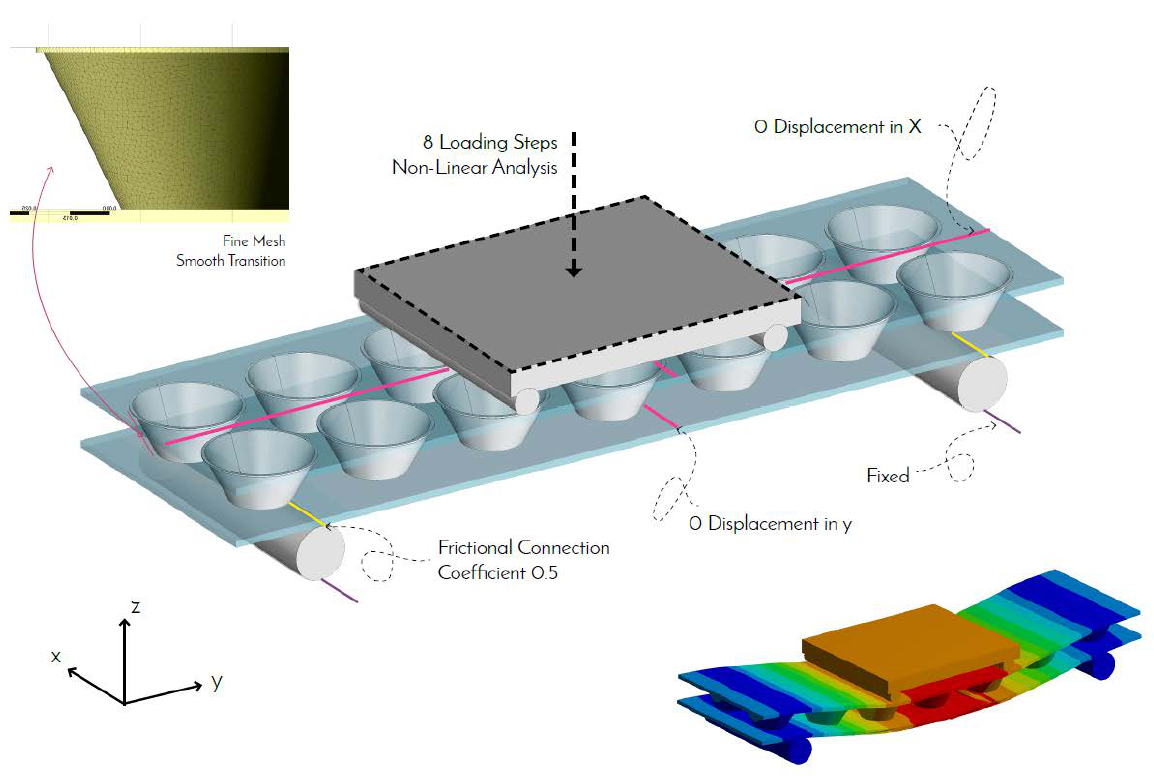
Fig. 5: Principles of structural model / simulation of bending